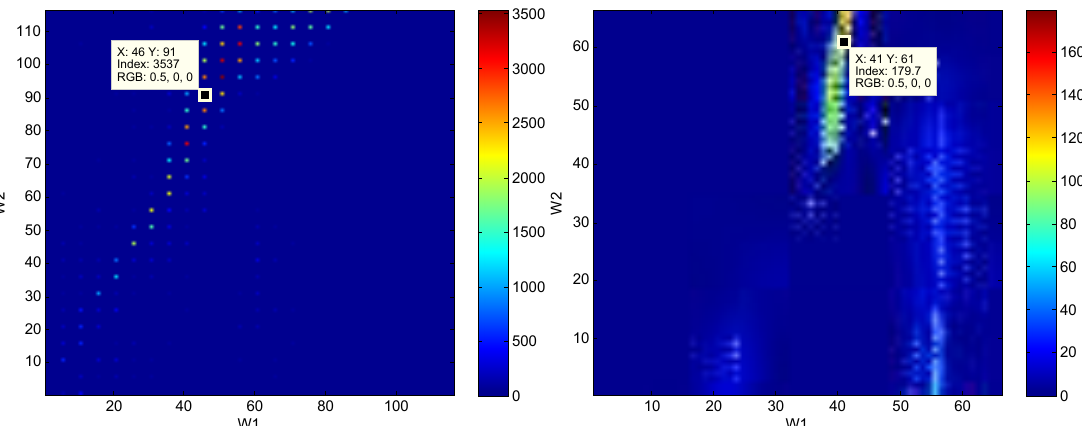
Figure 6. Eventogram for ECG signal ( left ) and PPG signal ( right ) shown in Figure 1. The red color indicates strong dominance of a main event while the blue color indicates non-existence of a main event. The eventogram is stored as a two-dimensional ( W 1 -by- W 2 ) array of integers in the range [1, length(colormap)]; colormap is a W 1 -by-3 matrix of real numbers between 0.0 and 1.0. The eventogram returns the index value in terms of W 1 and W 2 for the most dominant event that is associated with the red color or RGB (0.5,0,0)—the RGB color model is an additive color model in which red, green, and blue light are added together in various ways to reproduce a broad array of